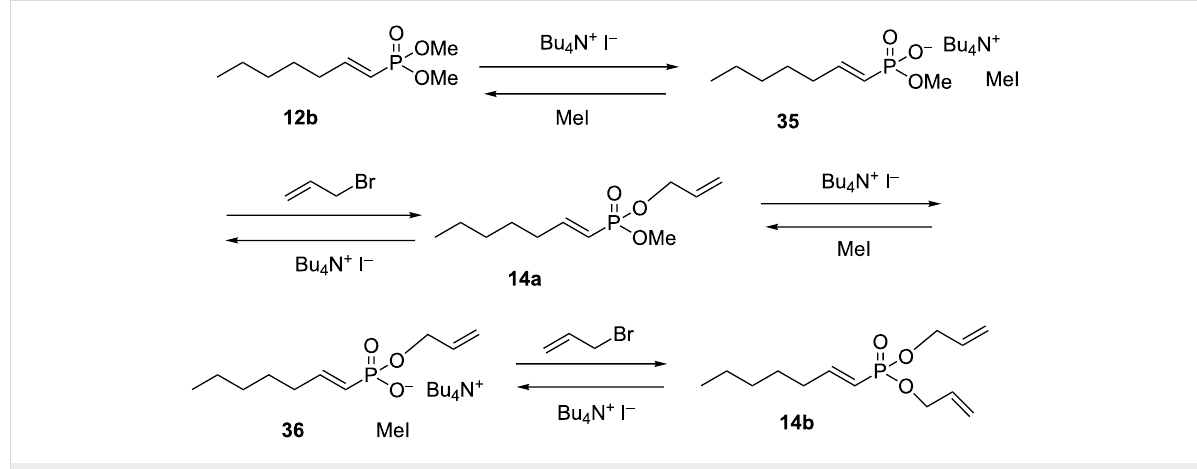
Scheme 12: A proposed mechanism for the TBAI catalysed transesterification.